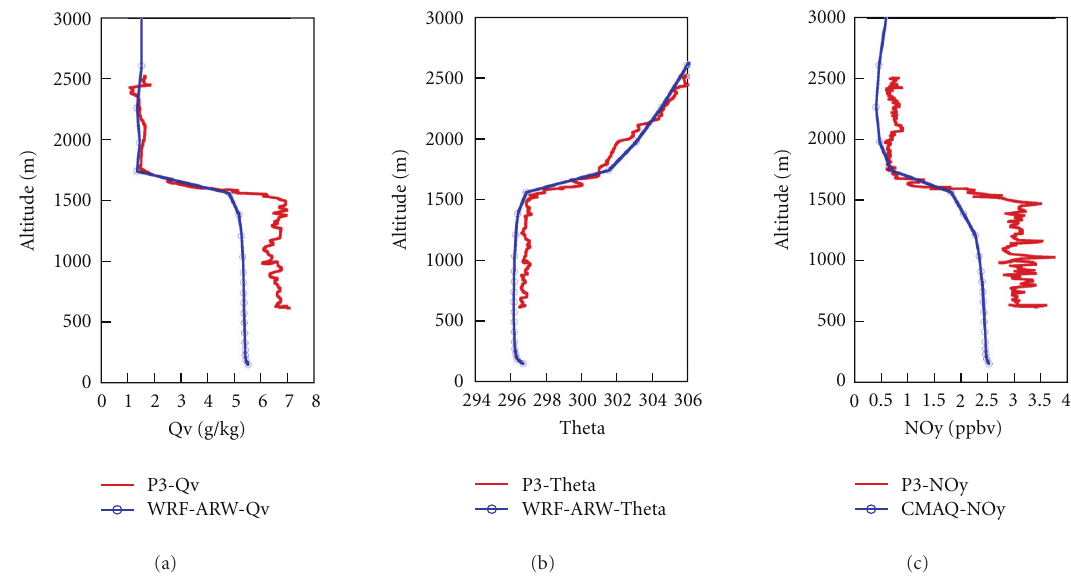
Figure 1: Comparisons of WRF and CMAQ model results compared to measurements from an NOAA WP-3D aircraft spiral on September 25, 2006 at